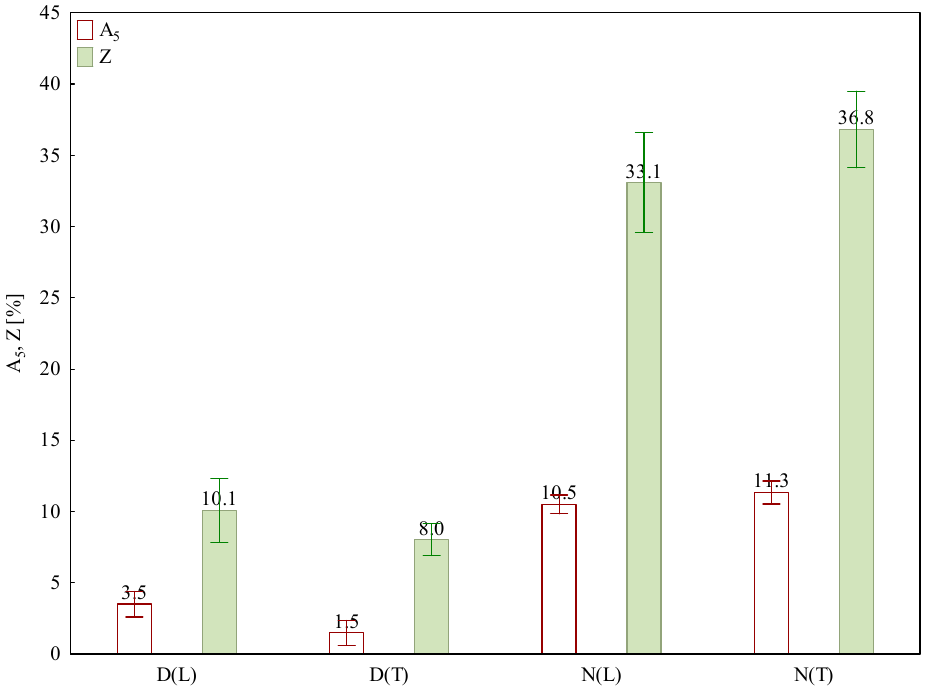
Figure 7. Elongation ( A 5 ) and reduction in area ( Z ) at break of Hardox Extreme steel in delivery and normalized states.